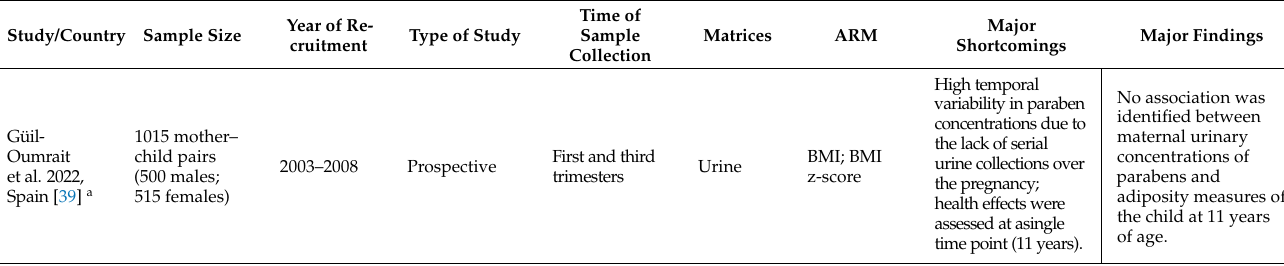
Table 1. Association of paraben exposure in utero and adiposity-related measures